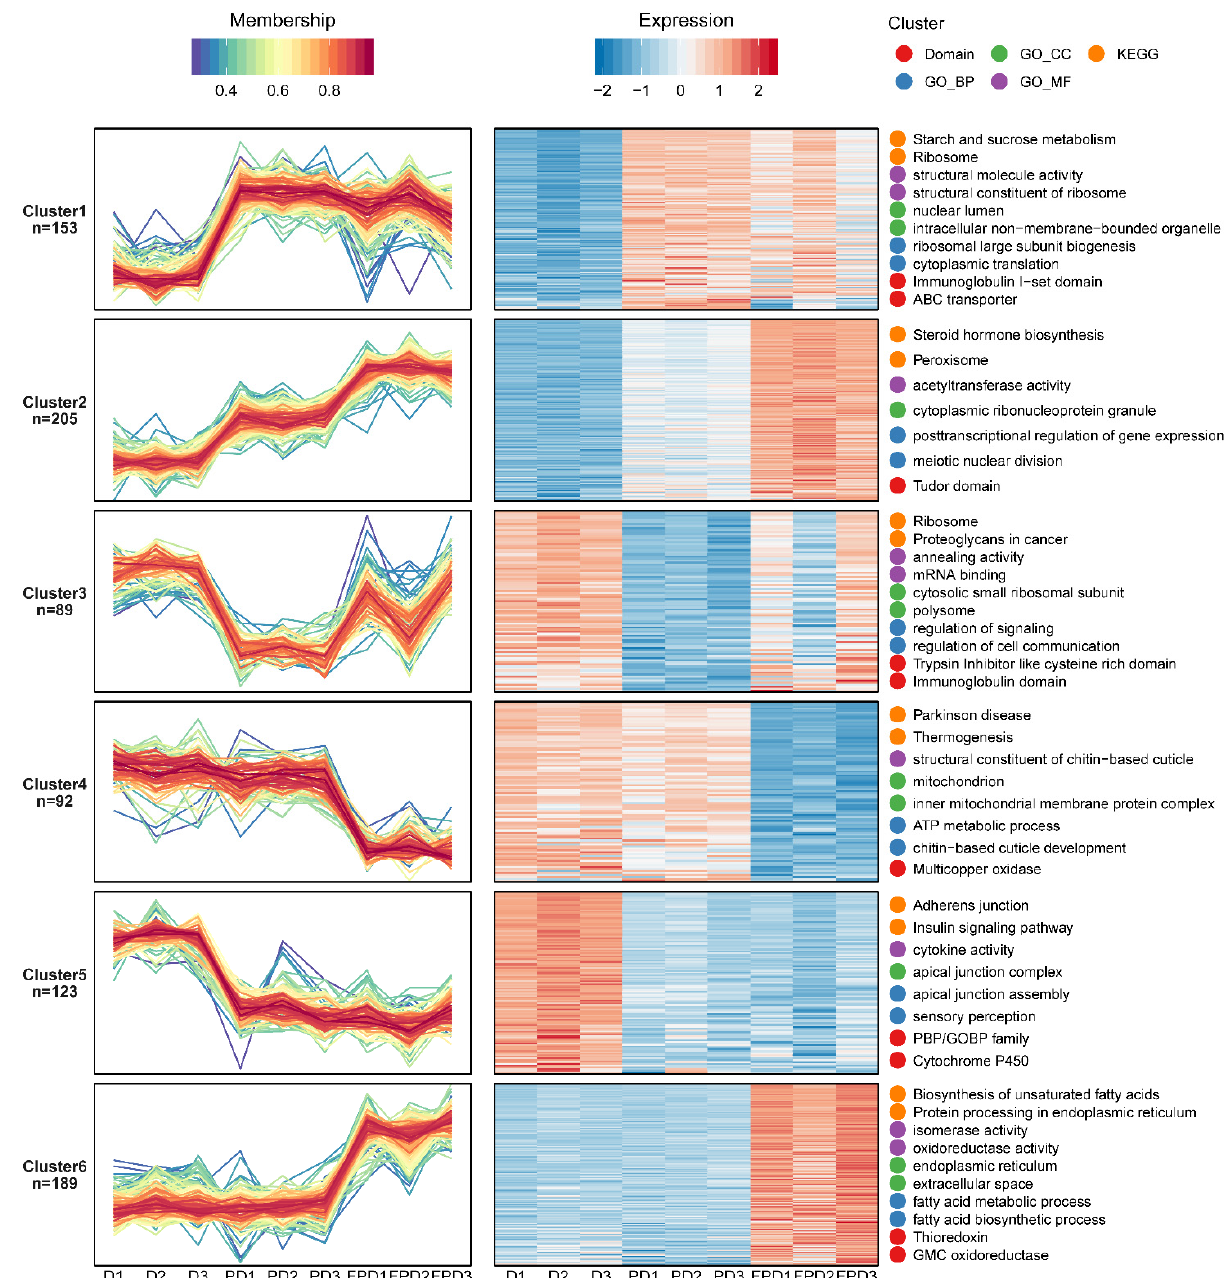
Figure 3. Functional clustering of differentially expressed proteins. Fuzzy clustering algorithm was used to identify coregulated protein modules. The two most highly enriched GO/KEGG/domain entries are displayed on the right side of the corresponding cluster graph.